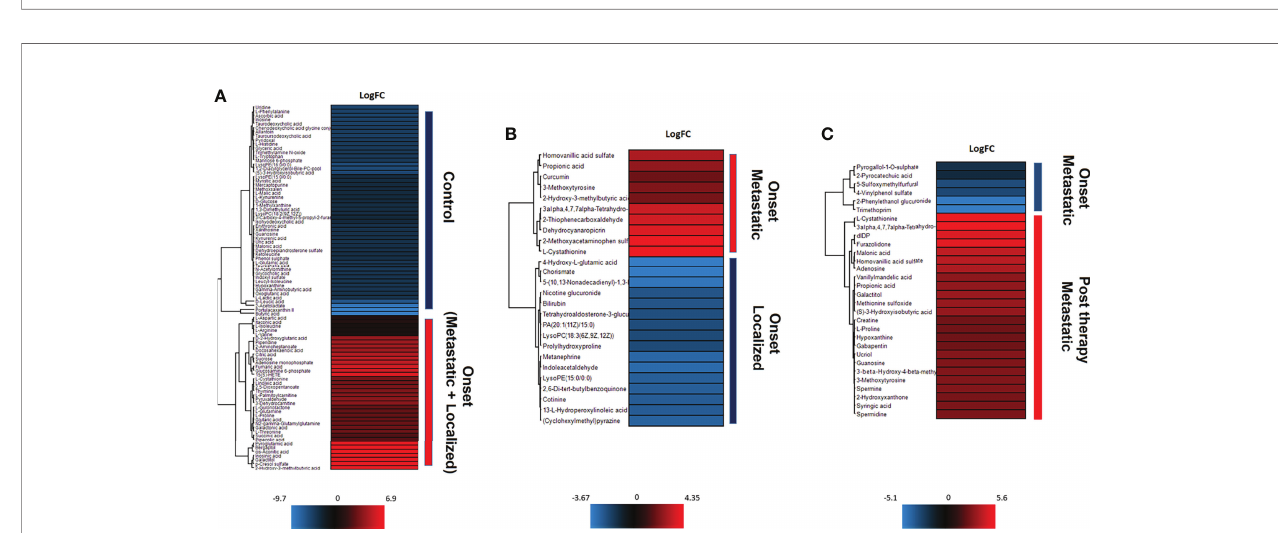
FIGURE 1 | Overview of raw data manipulation, reduction of the number of features queried by statistical analysis.